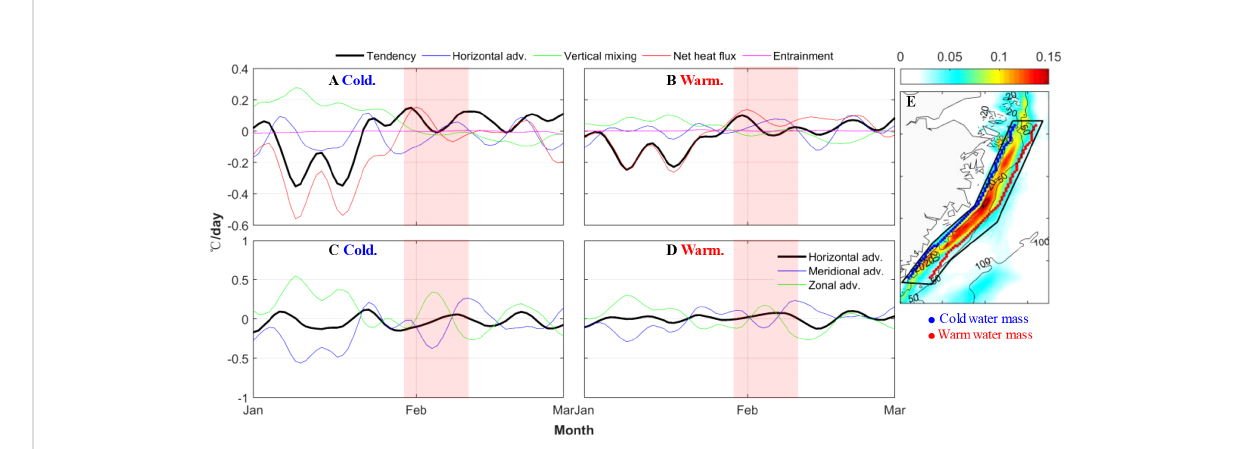
FIGURE 12 (A, B) Time series of the terms of the heat budget equation in cold water (blue dots in E ) and warm water (red dots in E ), the red shaded represents the same abrupt change period as Figure 3. (C, D) Zonal and meridional components of the horizontal advection in cold and warm water. (E) Average modeled SST gradient of January to March, 2021, and the points used for heat budget analysis.